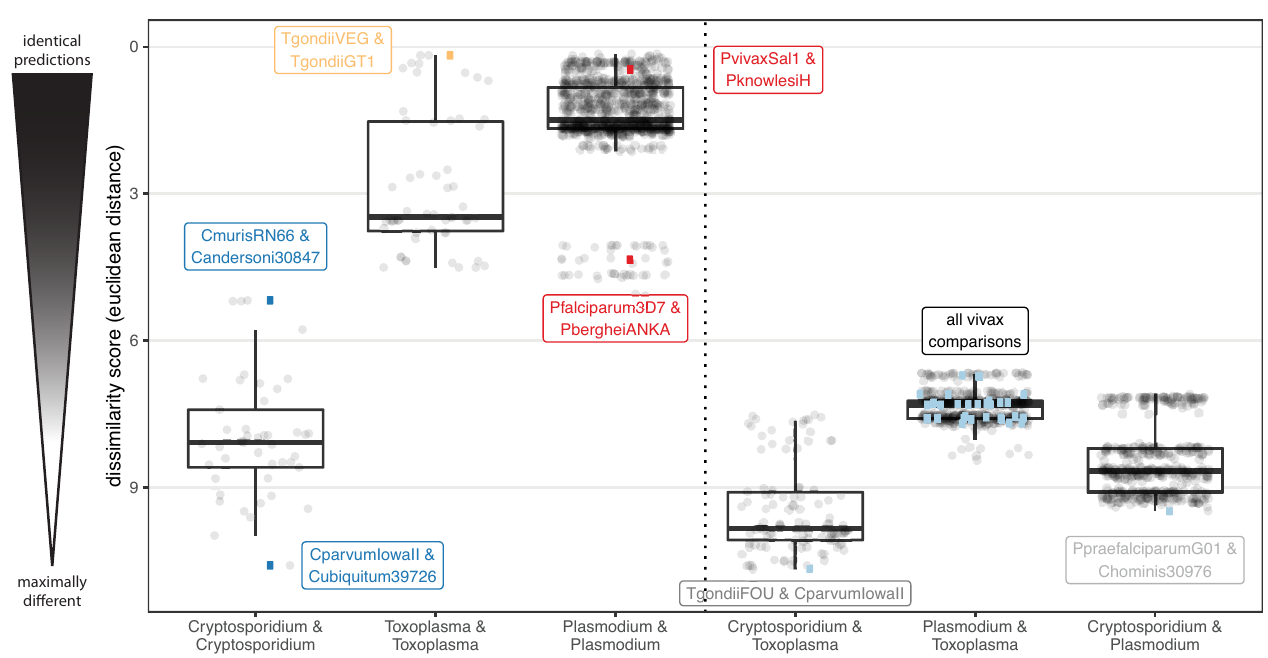
Fig 7. Selecting experimental model systems using reaction essentiality. Single reaction knockouts were performed on unconstrained models to identify the reactions that are essential for generating biomass. Dissimilarity scores were calculated from binary essentiality results using Euclidean distance (root sum-of- squares of differences). A low dissimilarity score of 0 indicates enzyme essentiality is identical between the two models; a high score indicates many differences. Each point represents a pairwise comparison with genera labels on the x-axis. Within genus comparisons are made on the left; across genus comparisons are made on the right. Several examples are highlighted with genome names. Genome-wide reaction essentiality is more similar between Toxoplasma and Cryptosporidium than Toxoplasma and Plasmodium . Mean dissimilarity score is significantly different (by two-sided student’s t-test with multiple testing correction) between every labeled group.